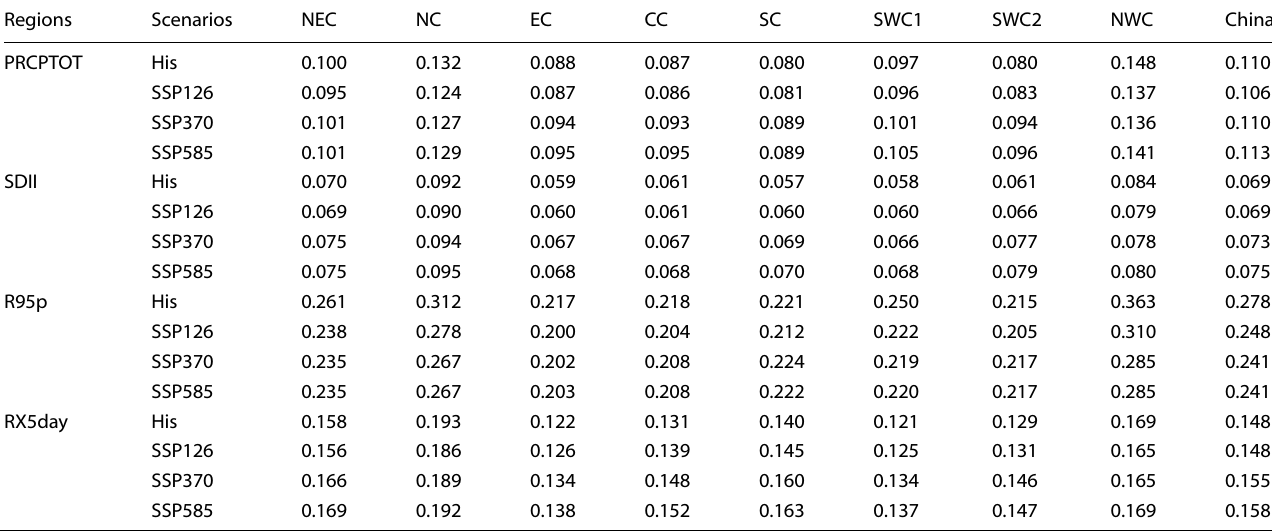
Table 2. Medium values of Gini in eight subregions and the whole of China for historical and future simulations.